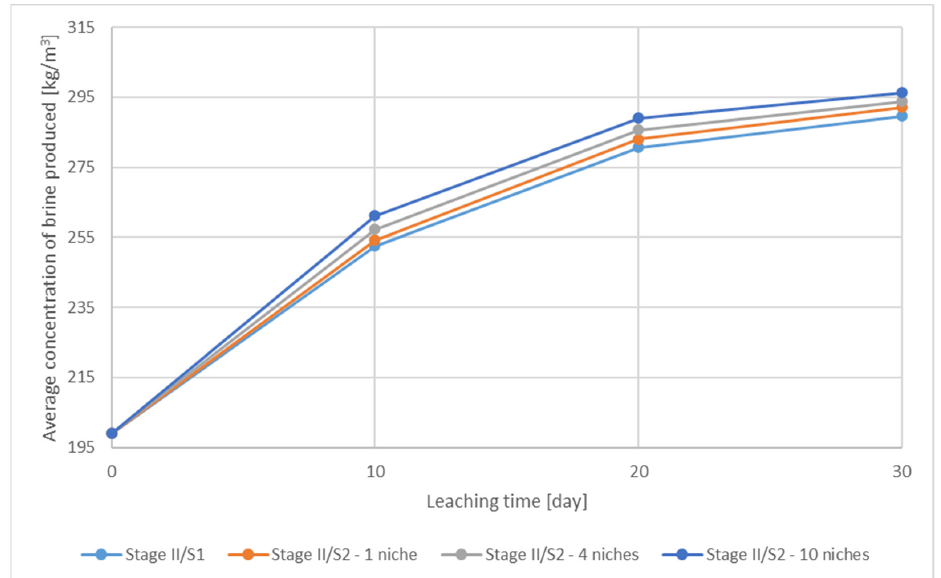
Figure 18. Comparison of changes in the brine concentration of the produced brine for I Phase of Stage II—the first 30 days for different scenarios.